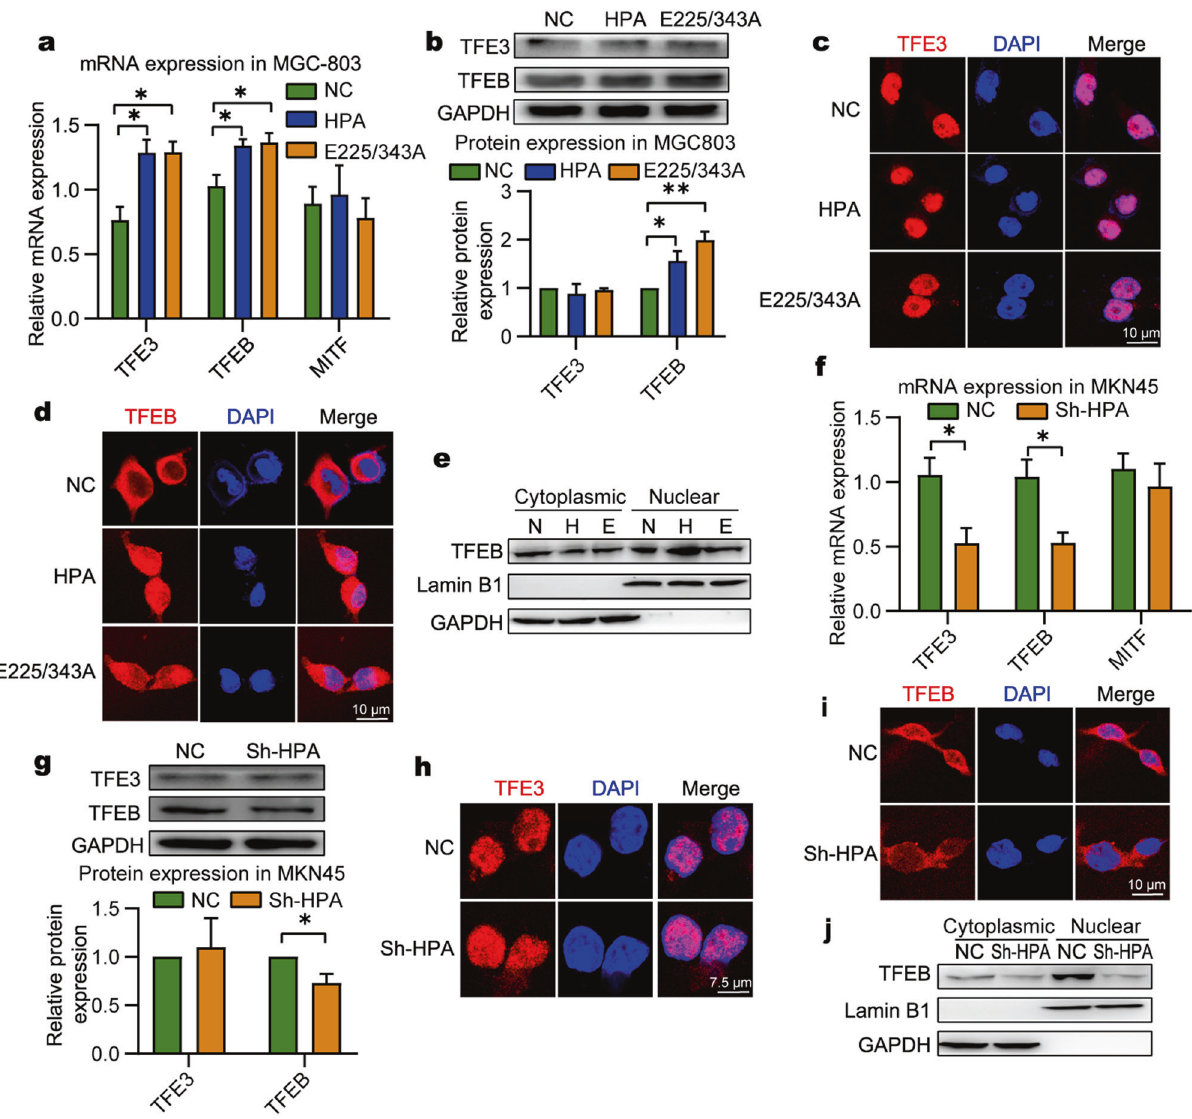
Fig. 5 Overexpression of wild-type and nonenzymatic HPA leads to nuclear translocation of TFEB. Relative gene expression of MiT/TFE family members in MGC803 cells overexpressing native or mutant HPA ( a ) or in MKN45 cells subjected to HPA-knockdown ( f ), and starvation. Representative image and quanti fi cation of TFE3 and TFEB protein expression in MGC803 cells overexpressing native or mutant HPA ( b ) or in MKN45 cells subjected to HPA-knockdown ( g ), and starvation. Representative image of TFE3 subcellular localization in MGC803 cells overexpressing native or mutant HPA ( c ) or in MKN45 cells subjected to HPA knockdown ( h ), and starvation. Immuno fl uorescence images of TFEB nuclear translocation in MGC803 cells overexpressing native or mutant HPA ( d ) or in MKN45 cells subjected to HPA knockdown ( i ), and starvation. Cells were subjected to nuclear and cytoplasmic fractionation in MGC803 cells overexpressing native or mutant HPA ( e ) or in MKN45 cells subjected to HPA-knockdown ( j ), and starvation. Protein level of TFEB were analyzed using western blotting. Lamin B1 and GAPDH were used as the nuclear and cytoplasmic markers, respectively. * P < 0.05, ** P < 0.01 versus the NC